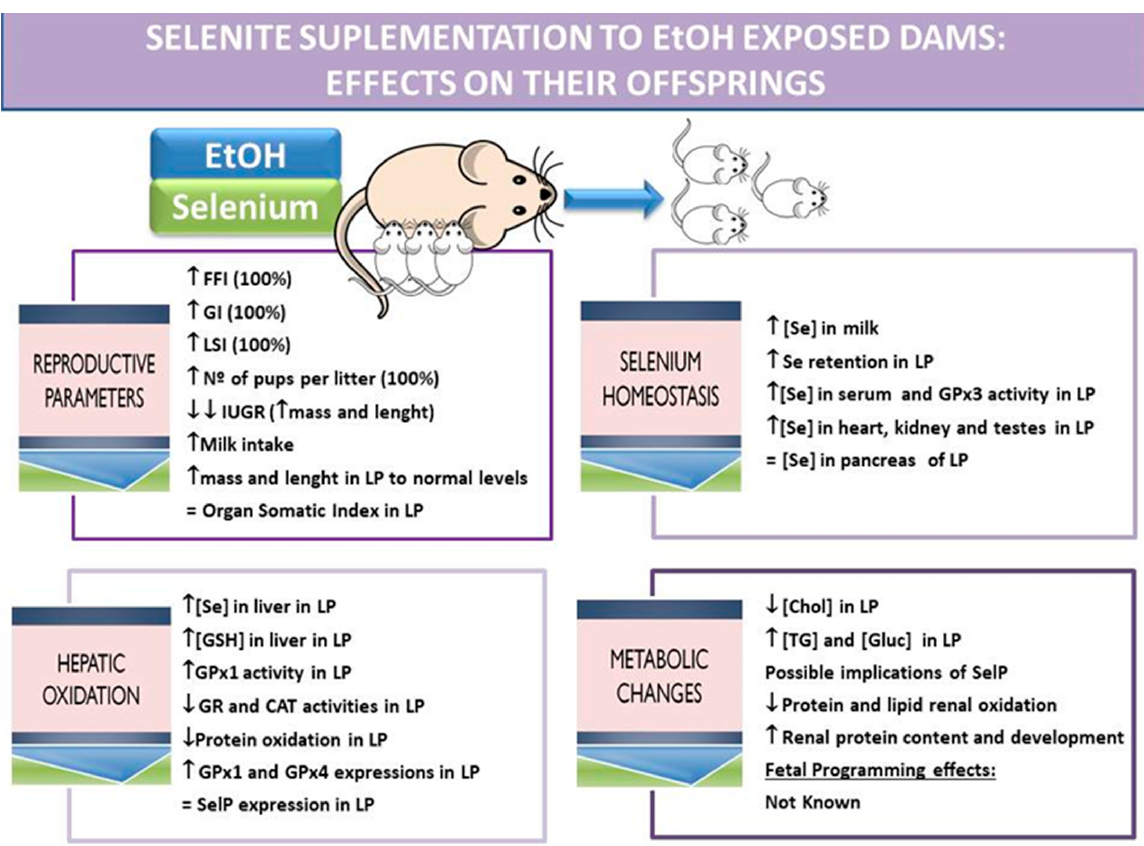
Figure 3. Dietary selenite supplementation to EtOH-exposed dams: effects on their offspring related to reproductive parameters, selenium homeostasis, hepatic oxidation and metabolic changes. The results are extracted from a chronic EtOH exposure model supplemented with Se in the diet applied to mothers during pre-conception, gestation and lactation periods carried out by this Research Group. FFI: fertility female index (number of pregnancies/number of mating × 100), GI: gestation index (number of successful births/number of pregnancy rats × 100), LSI: lactation survival index ((number of total offspring − number of died offspring/number of total offspring) × 100), IUGR: intrauterine growth retardation, LP: lactating pups, GSH: glutathione, GPx: glutathione peroxidase, CAT: catalase, GR: glutathione reductase, SelP: selenoprotein P, Chol: cholesterol, TG: triglycerides, Gluc: glucose.